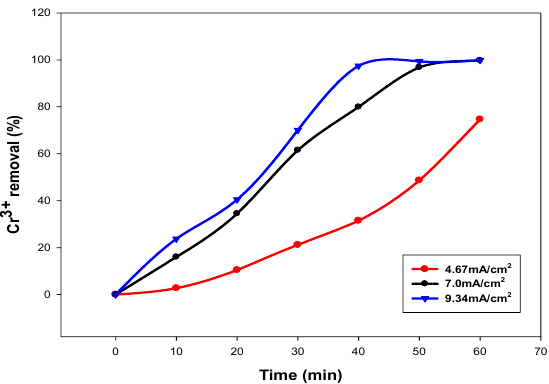
eventually the ultimate operating cost for the process. Current density during EC experiments were varied by changing cell current and as well as electrodes area. Figure 2 showed the effect of current density on EC at constant electrodes surface area (89.52 cm 2 ). Each of